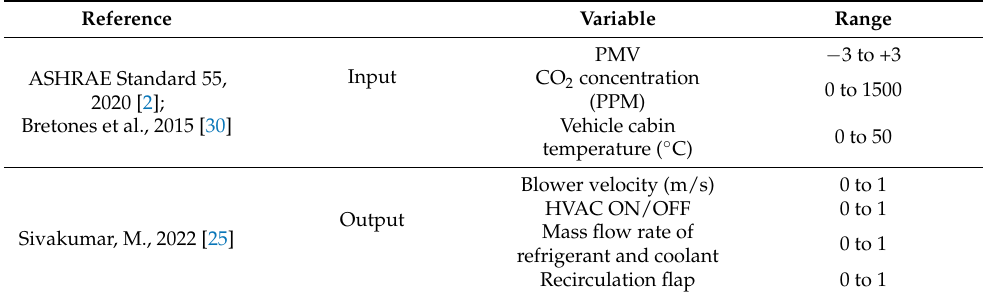
Table 2. Fuzzy logic membership range that was used as input and output